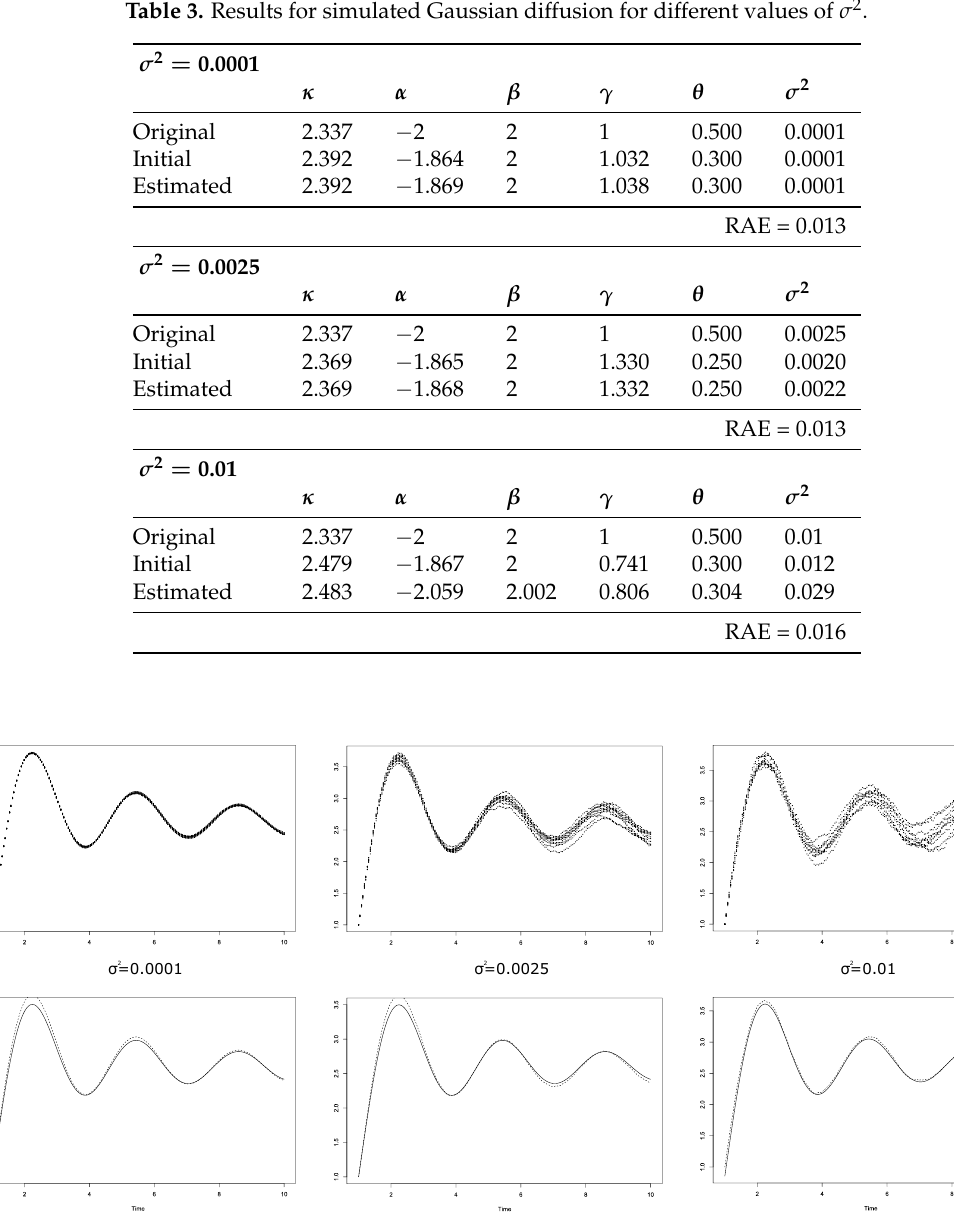
Table 3. Results for simulated Gaussian diffusion for different values of σ 2 .